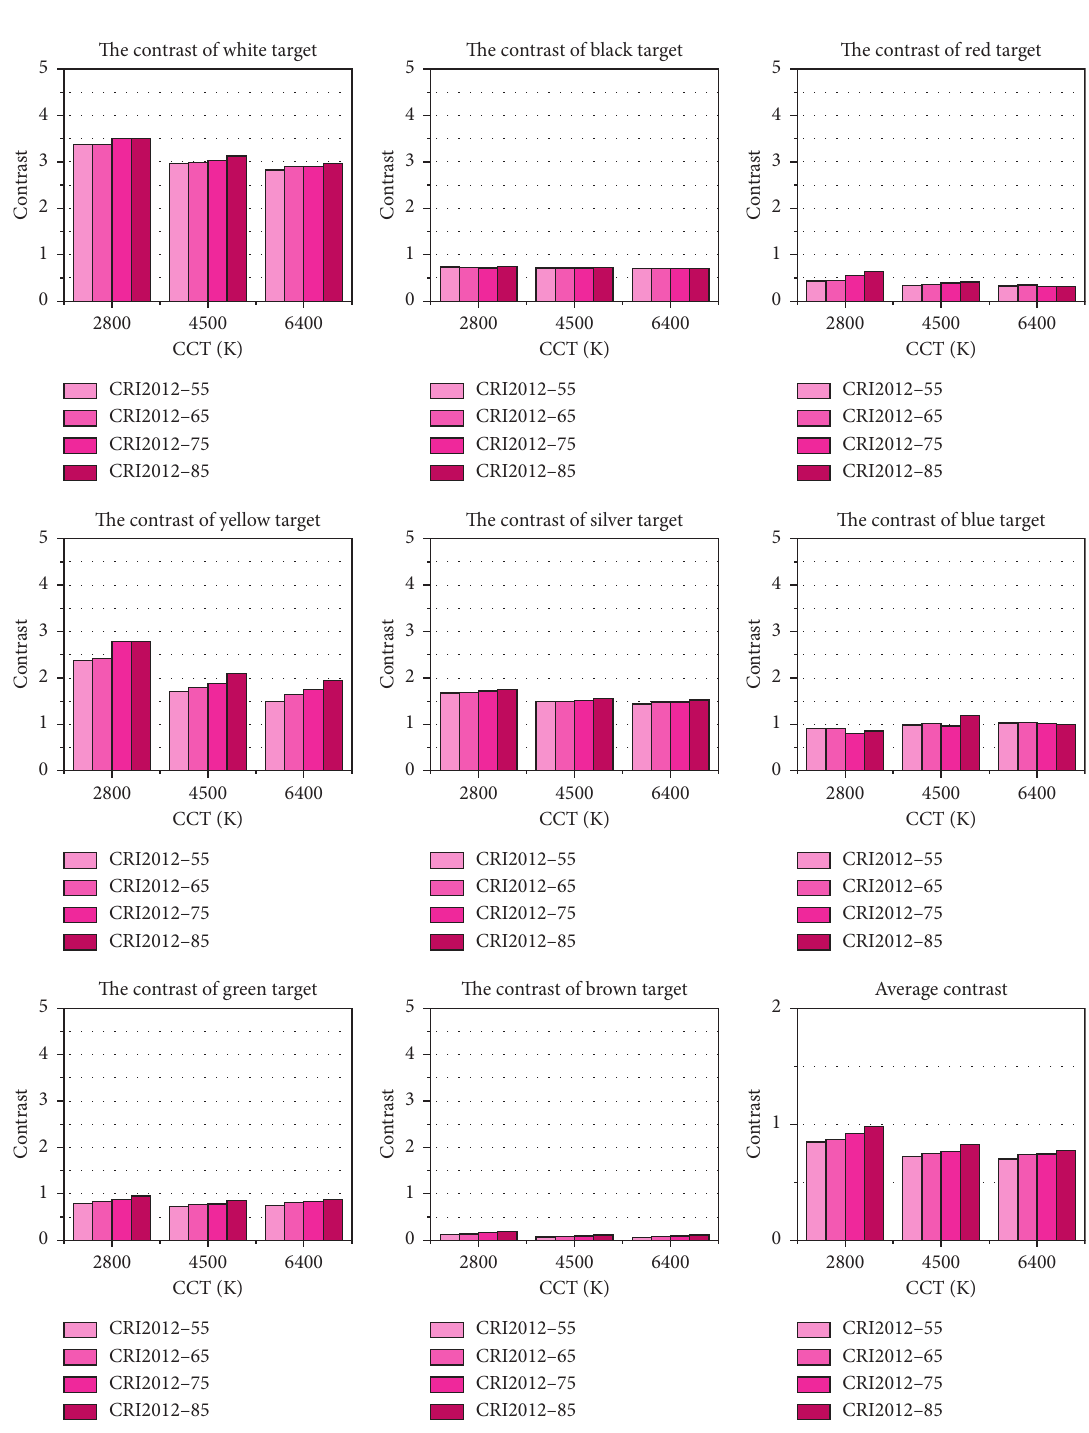
Figure 7: The calculation results of